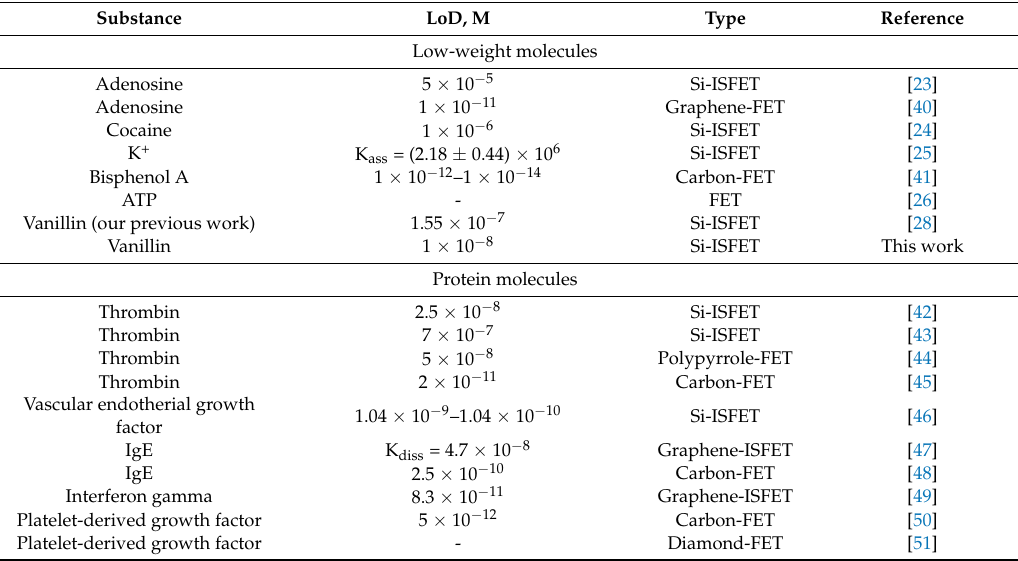
Table 2. Sensors based on FETs and aptamers presented in the literature.